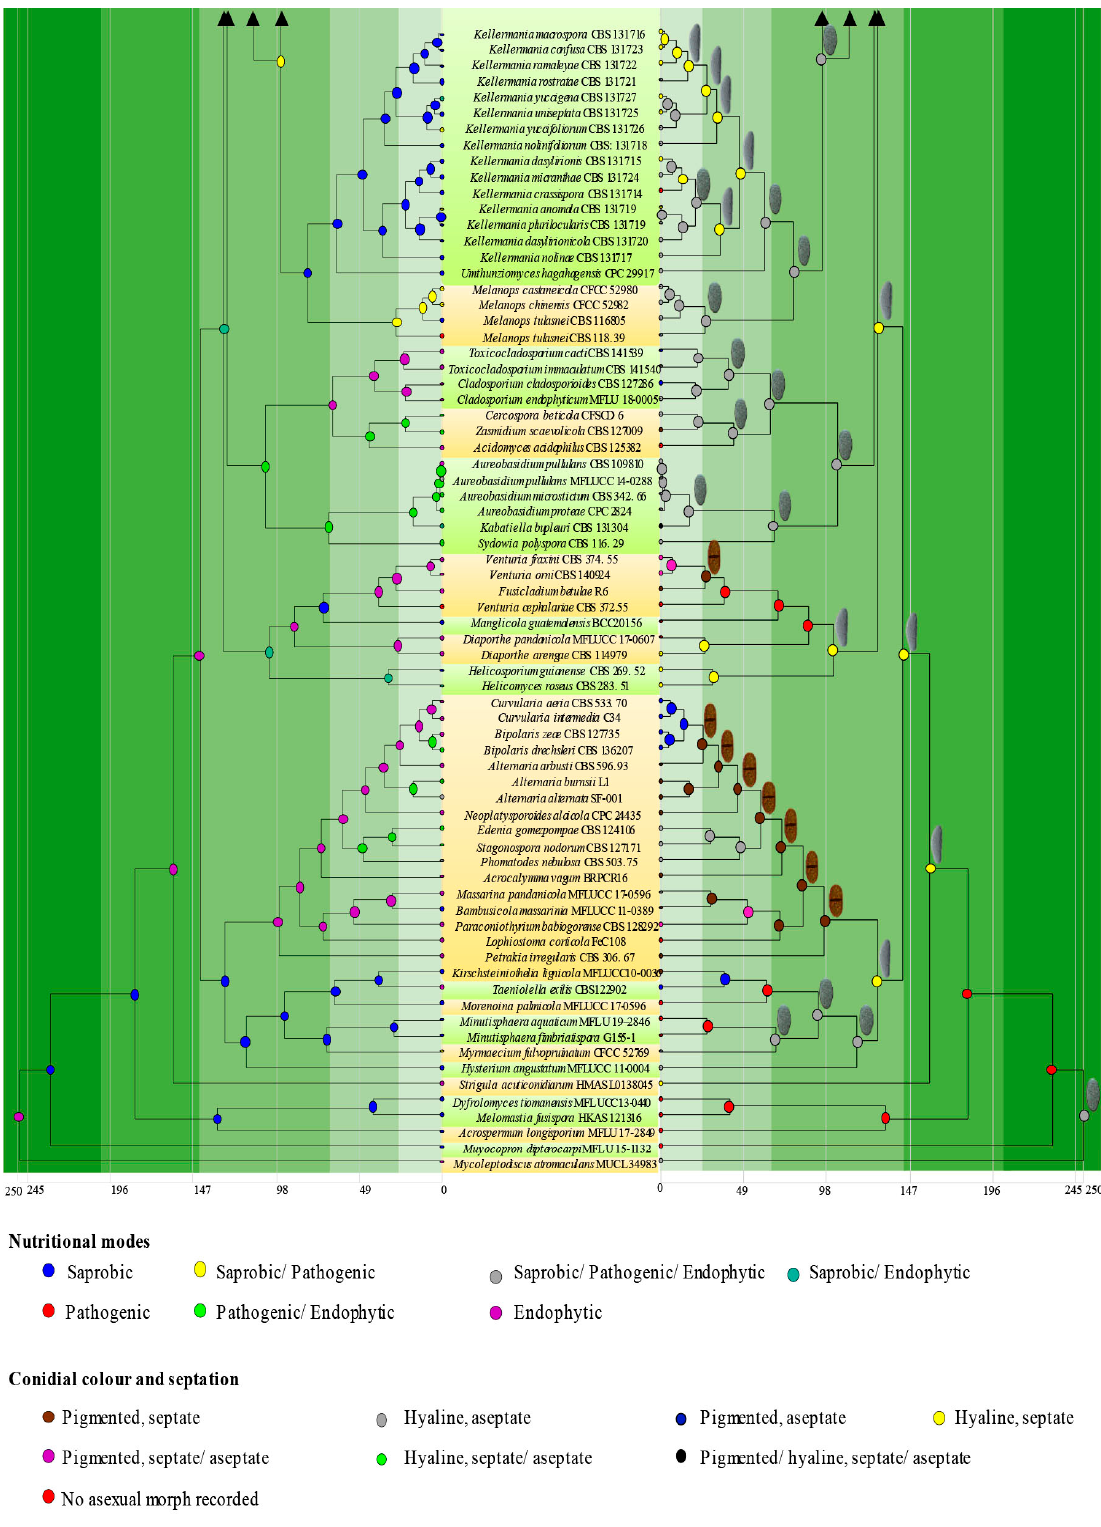
Figure 7. Ancestral character state analysis for nutritional mode (left) and conidial colour and septation (right) in Botryosphaeriales , using Bayesian Binary MCMC approaches. Pie charts at terminals show the most likely states (MLS) only and the internal nodes represent the marginal probabilities for each ancestral area.